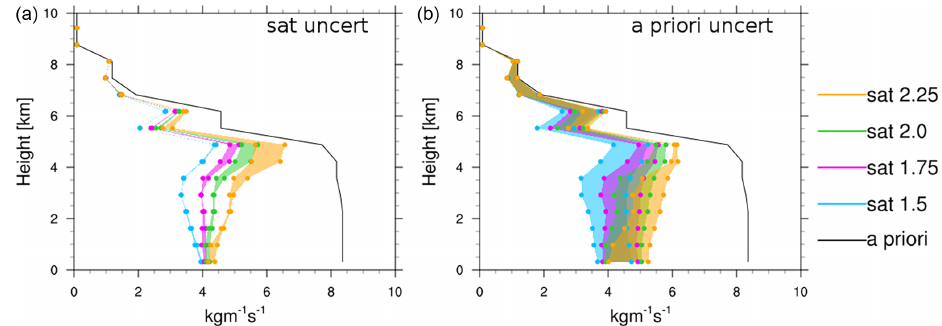
Figure 5. Spread of a posteriori for the four satellite data sets with the four different size distribution assumptions (sat 1.5–2.25). (a) shows the spread in a posteriori caused by varying the uncertainty connected to the satellite data, with a priori uncertainty set at 75%. (b) shows the spread in a posteriori caused by varying a priori uncertainty, with a constant satellite uncertainty at